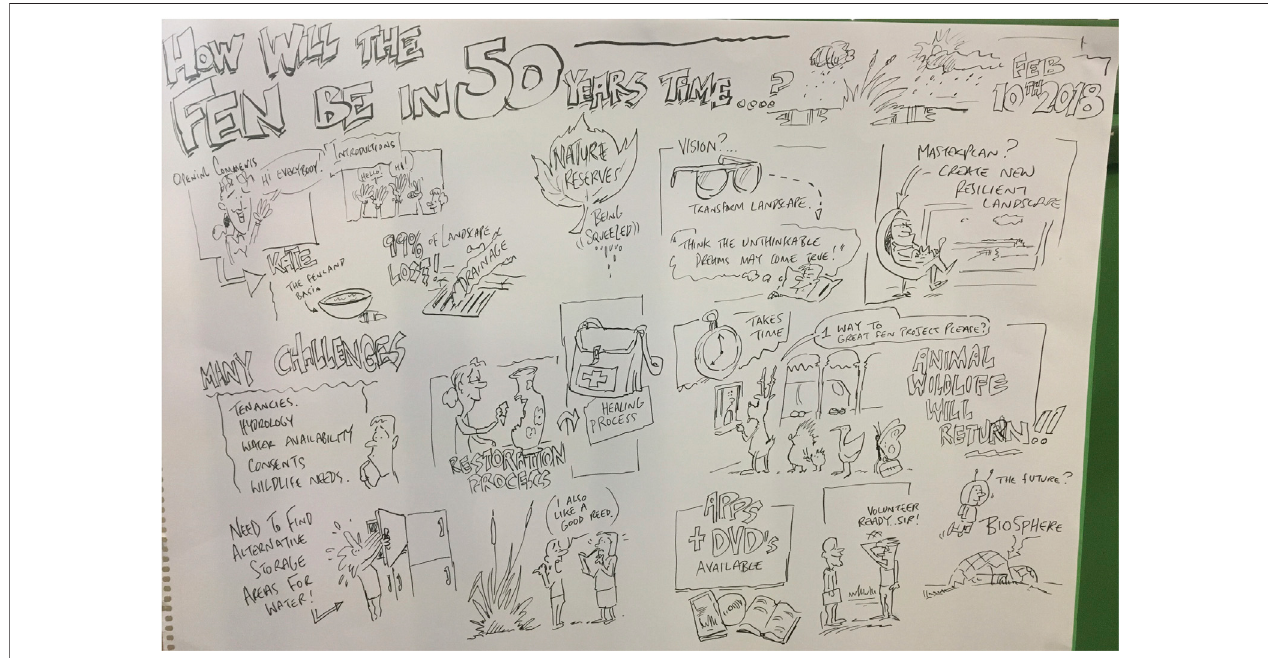
FIGURE 5 | Cartoon note-taking from the science-narrative scenario-ing